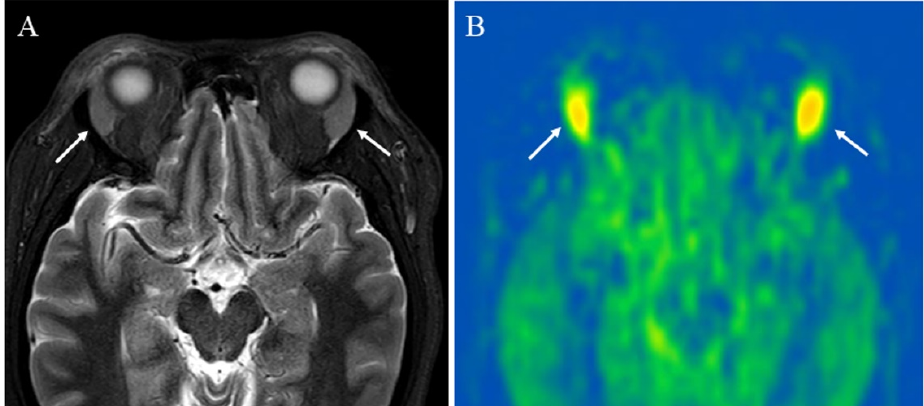
Figure 5. A 43-year-old female with immunoglobulin G4-related disease that involves the bilateral lacrimal gland: ( A ) Short tau inversion recovery (STIR) shows bilaterally enlarged lacrimal glands with high signal intensity (arrows); ( B ) pCASL image shows high blood flow within the lesions (arrows) (right mean of 65.70 mL/100 g/min and left mean of 66.98 mL/100